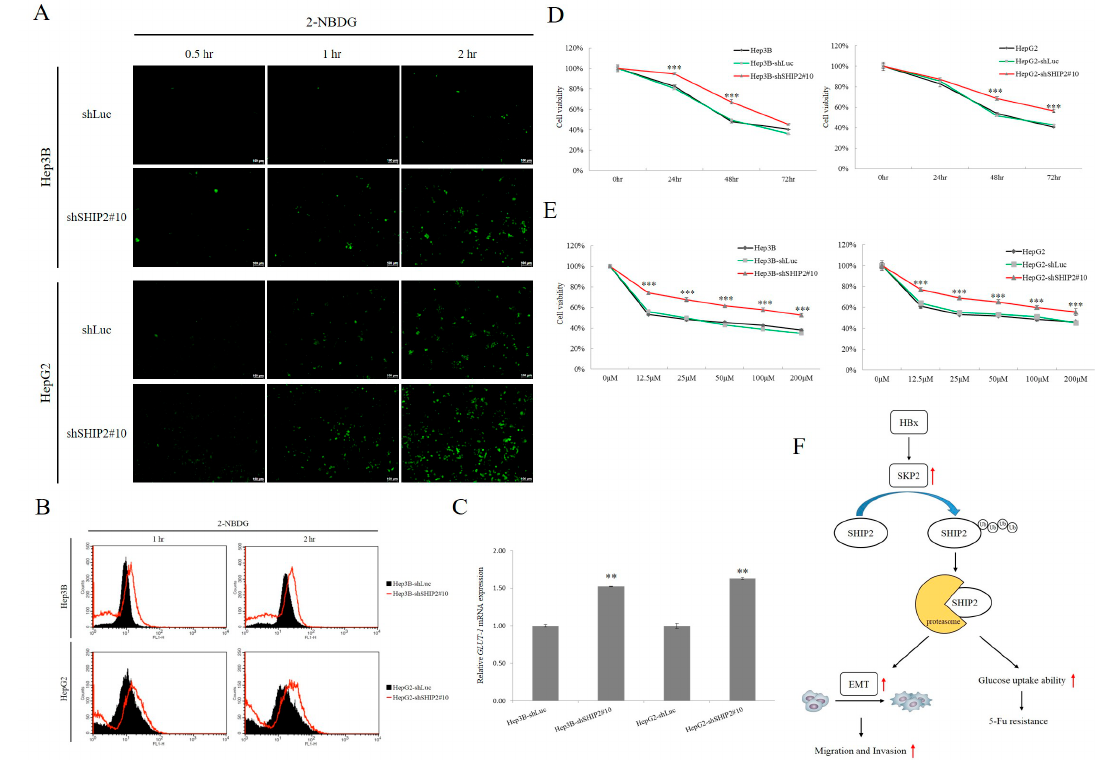
Figure 6. Inhibition of SHIP2 activates glucose uptake and 5-FU resistance in HCC cells. ( A , B ) Time-dependent glucose uptake in HCC cells following SHIP2 knockdown. Glucose uptake was analyzed with the fluorescent deoxyglucose analog 2-NBDG by fluorescence microscopy and flow cytometry. Tumor cells were incubated with 50 nM 2-NBDG for 0.5, 1, and 2 h. The lentivirus containing shRNA against luciferase (shLuc) was used as the control. Representative data from three independent experiments are shown. ( C ) GLUT1 mRNA expression in SHIP2-knockdown HCC cell lines was examined by real-time PCR. GLUT1 mRNA expression was normalized to actin expression. ** p < 0.01 ( D , E ) The cytotoxic effect of 5-FU in SHIP2-knockdown HCC cells was analyzed. Hep3B and HepG2 cells were plated in 96-well plates after shLuc or SHIP2 knockdown for 72 h. The parental lines were also plated as additional controls. The cells were treated with the indicated doses (12.5–200 µ M) of 5-FU for 48 h or were treated with a time course of 25 µ M 5-FU for 24, 48, and 72 h. After 5-FU treatment, cell survival was monitored using the WST-1 assay. Statistical analysis was carried out with Student’s t -test. *** p < 0.001 as compared with each control group ( n = 3). ( F ) Schematic diagram depicting how HBx mediates SHIP2 in HCC cells.